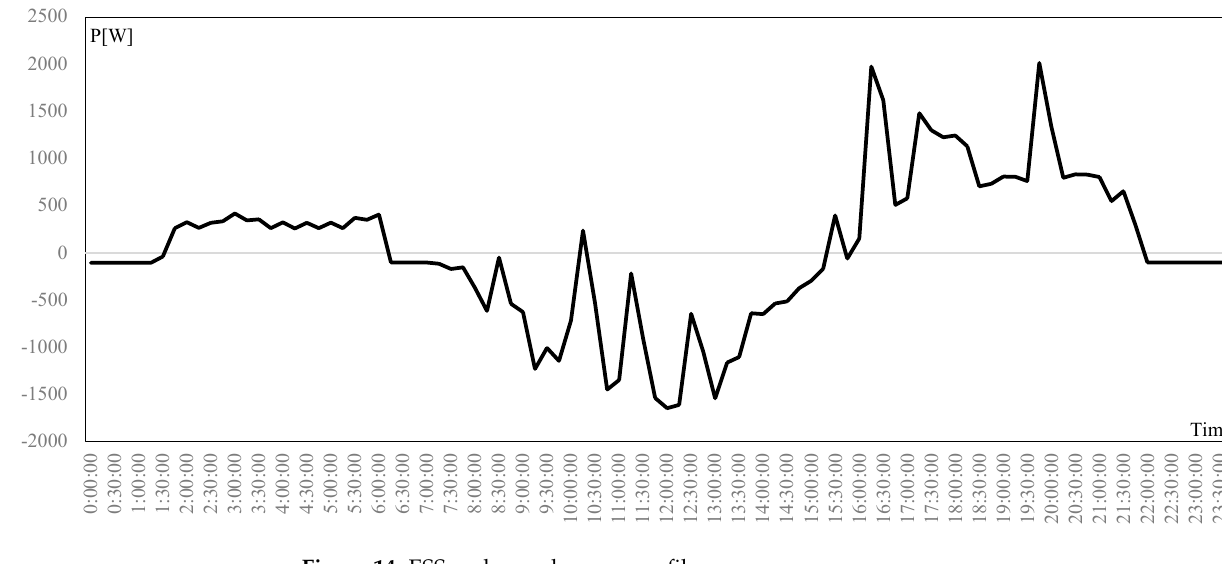
Figure 14. ESS exchanged power profile.